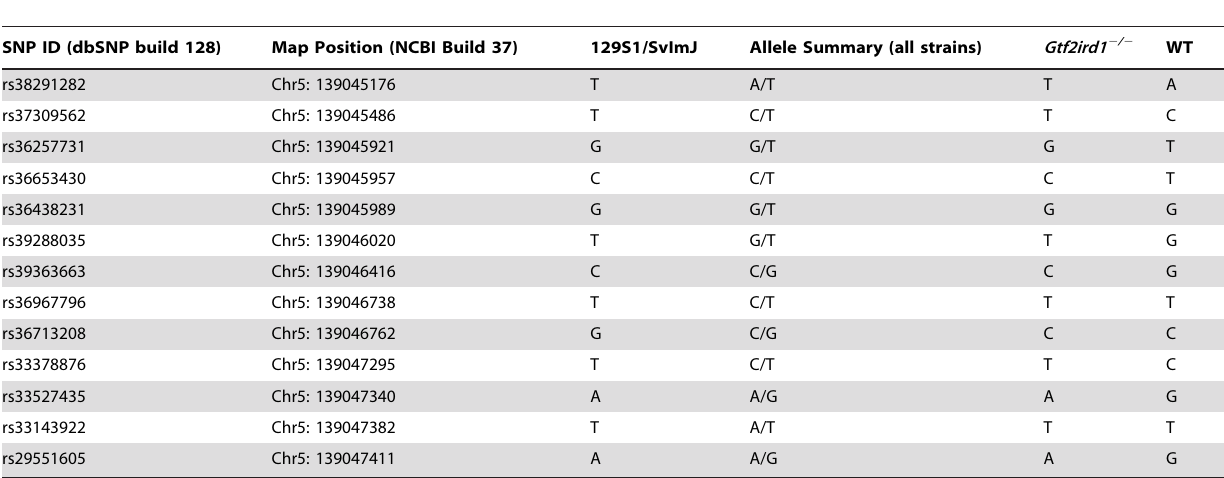
Table 1. A comparison of SNPs in the 3 9 UTR Zfp68 in Gtf2ird1 2 / 2 mice and WT mice relative to 129S1/Sv1mJ mice.